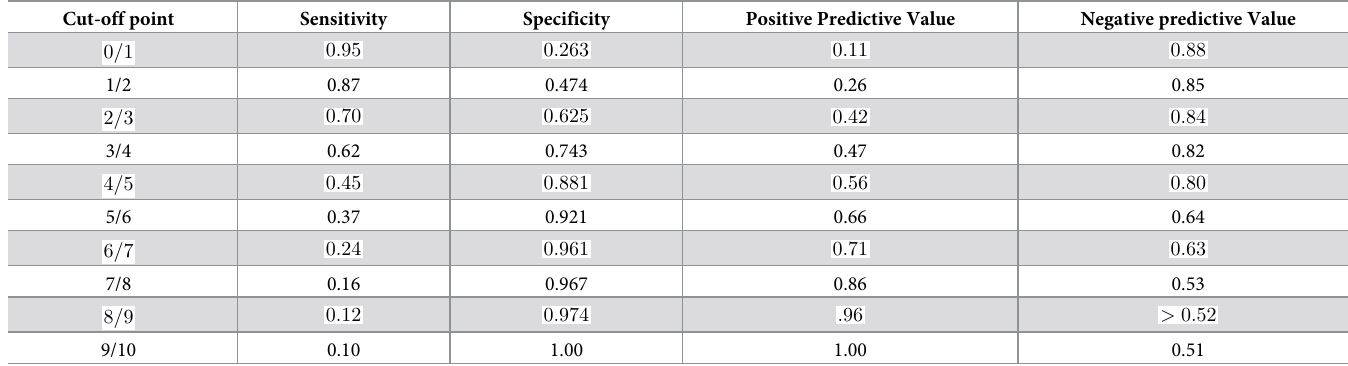
Table 1. Sensitivity, specificity, positive and negative predictive values for each of the distress thermometer cutoff points among 247 cancer